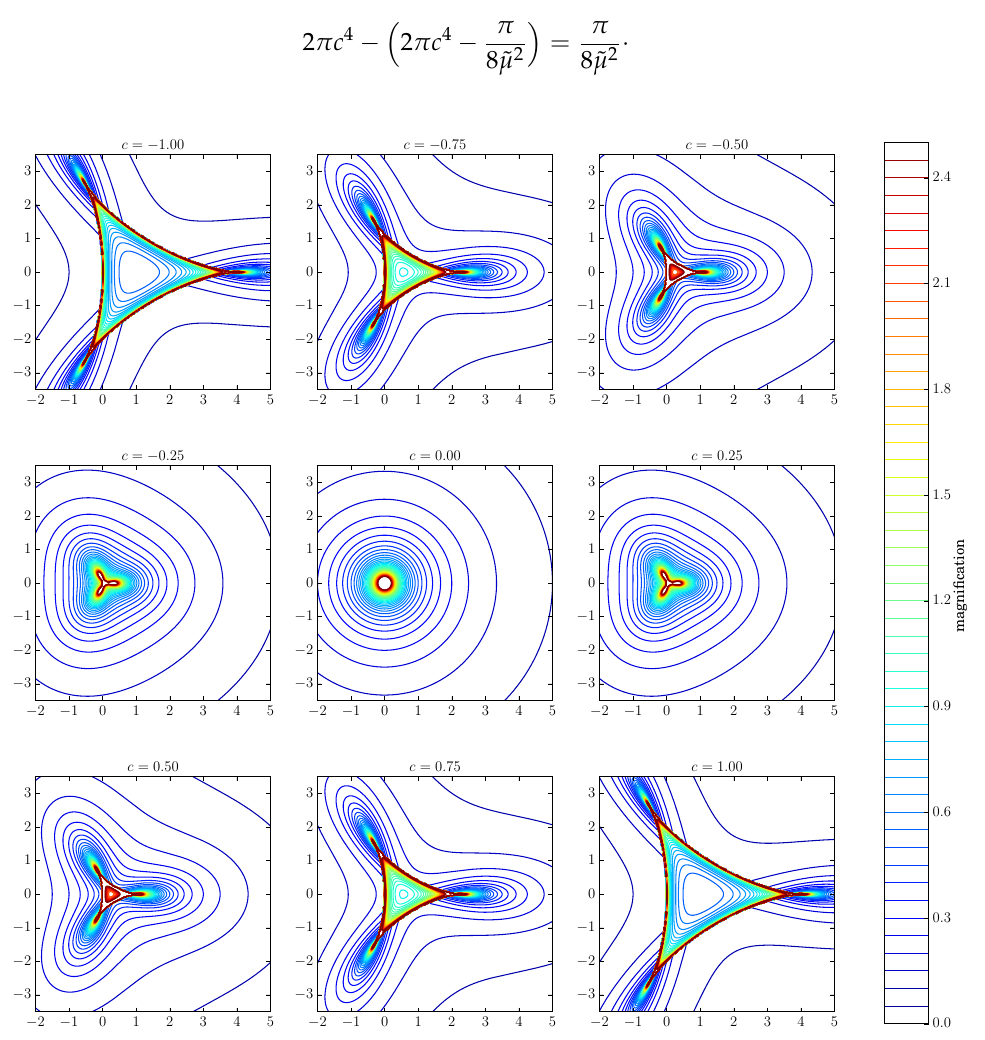
Figure 3. Level curves of the total unsigned magnification, for different values of c .